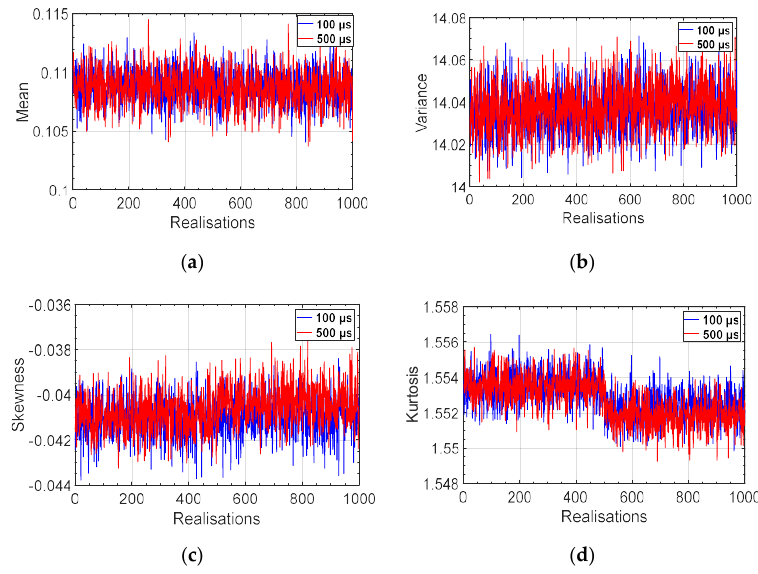
Figure 8. Statistical moments for two OSF durations with SNR = 20 dB: ( a ) With mean value, ( b ) With variance, ( c ) With Skewness, ( d ) With Kurtosis.